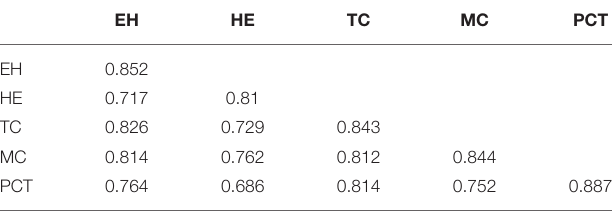
TABLE 4 | Discriminant validity (HTMT ratio).